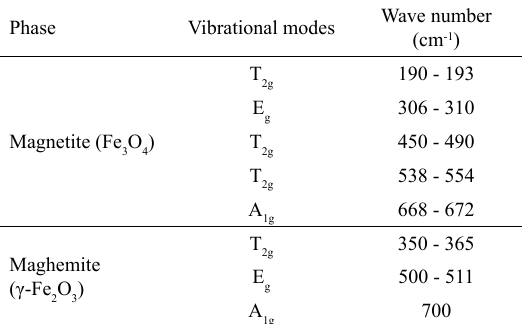
Figure 4. Raman spectrum of hydrophilic nanoparticles (A) and the hydrophobic nanoparticles (B), including analysis of the peaks using the Origin software. Table 1: Vibrational modes of the magnetite and maghemite phases in Raman spectroscopy 27–29